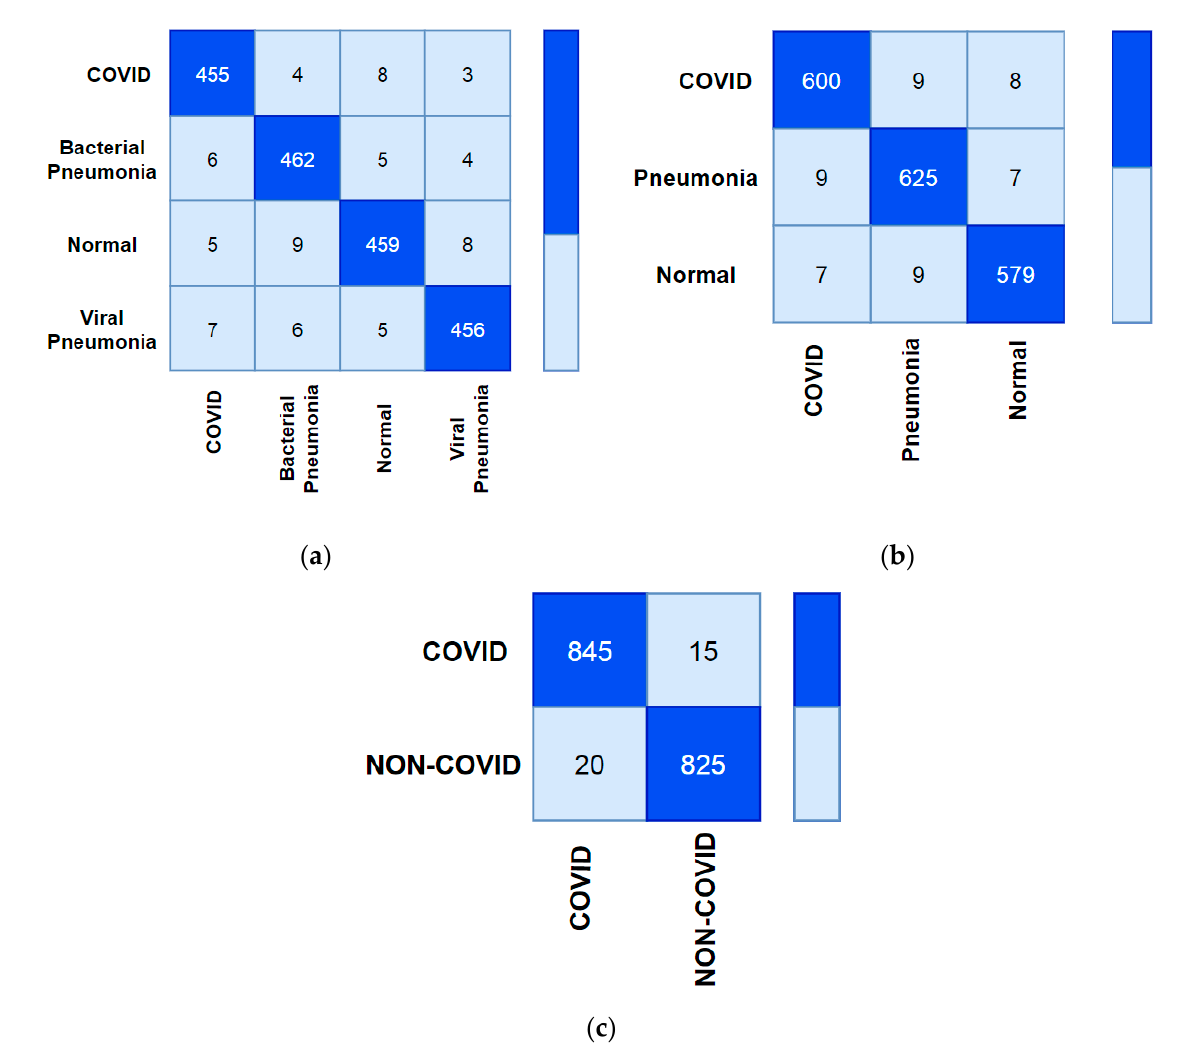
Figure 7. Confusion Matrix of C19D-Net model ( a ) four-class, ( b ) three-class, ( c ) two-class.